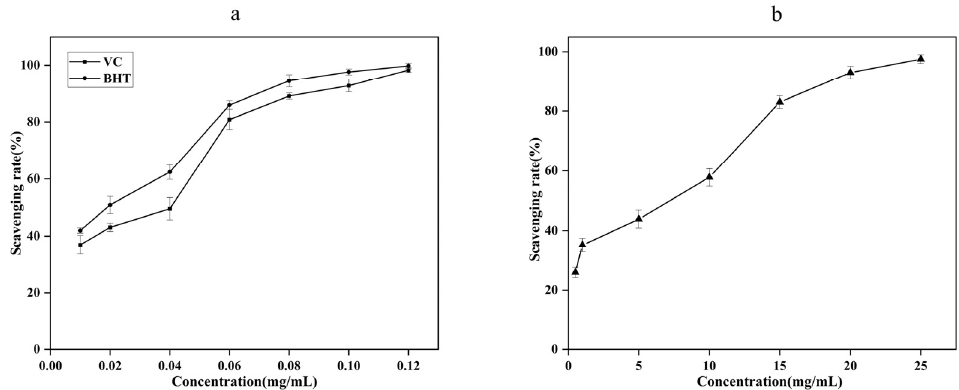
Figure 5. The clearance ability of VC, BHT ( a ) and AgEo ( b ) for ABTS